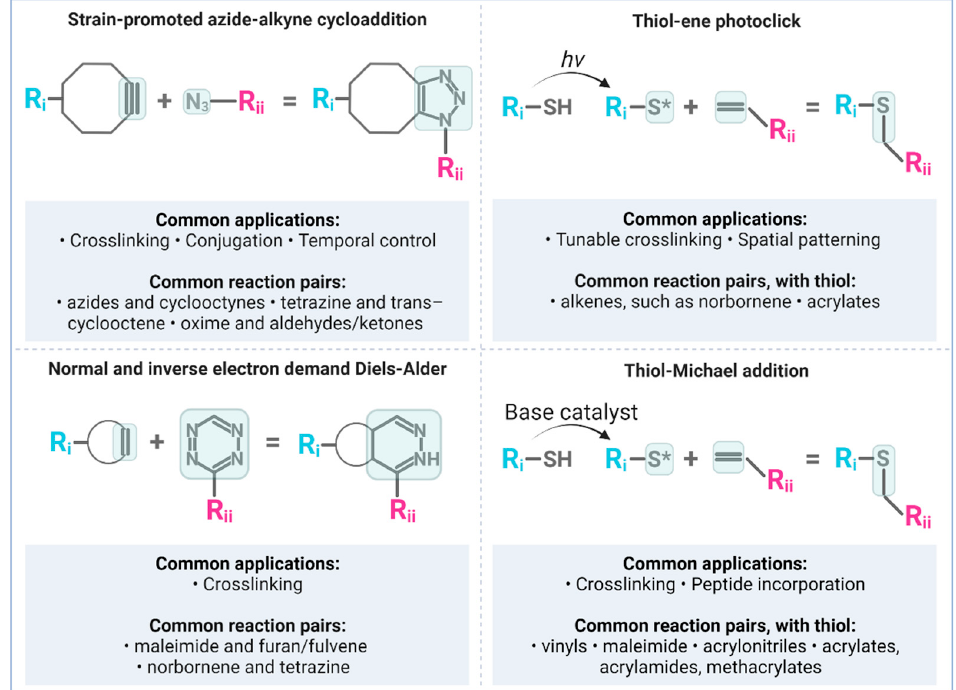
Figure 2. Bioorthogonal reaction schemes commonly used in biomaterials, including their respective applications and reactive functional groups. Created with Biorender. applications and reactive functional groups. Created with